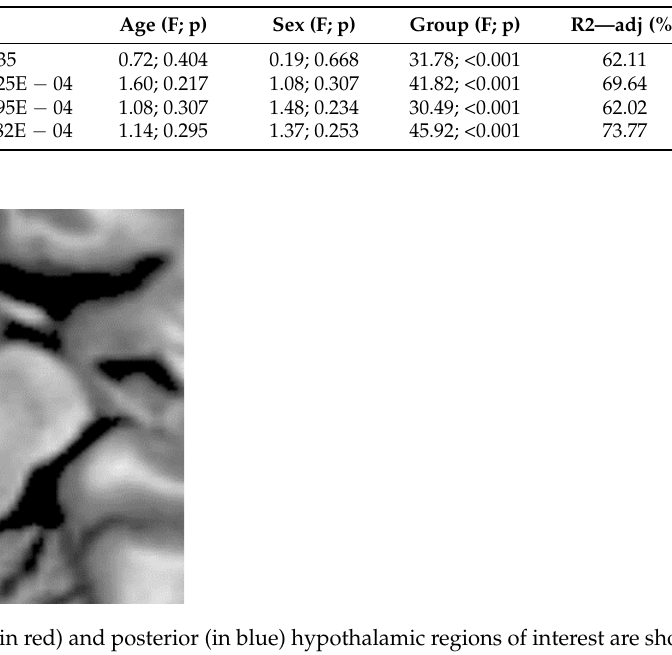
Table 2. Mean ± standard deviation for the hypothalamus fractional anisotropy (FA), mean diffusivity (MD), axial diffusivity (AD), and radial diffusivity (RD) in HC and MI. General linear models of DTI metrics inferences with the percentage of variation in the response that is explained by the model, adjusted for the number of predictors.